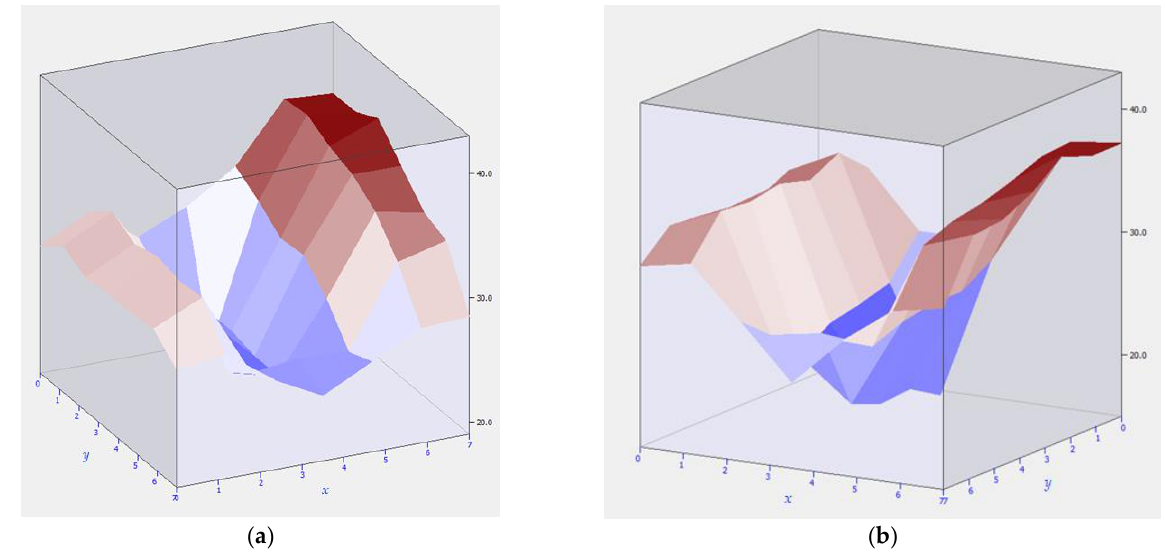
Figure 6. Overheating of the cathode part of the electrolysis cell bottom: ( a ) Hearth bottom with pronounced overheating of the right side (cathode 12); ( b ) Hearth bottom with pronounced over- heating of both cathodes (cathodes 17 – 18).